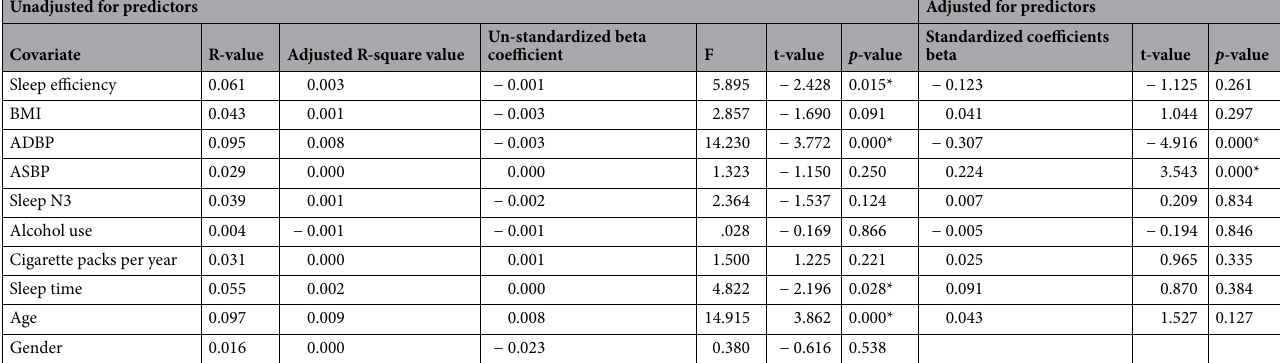
Table 3. Multiple linear regression analysis. Association of the number of angina episodes with sleep efficiency, BMI, average diastolic blood pressure, average systolic blood pressure, percent time in stage N3 of sleep, alcohol use, cigarette use, sleep time, age, and gender. BMI: body mass index; ADBP: average diastolic blood pressure; ASBP: average systolic blood pressure; Sleep N3: percent time in stage N3 of sleep.